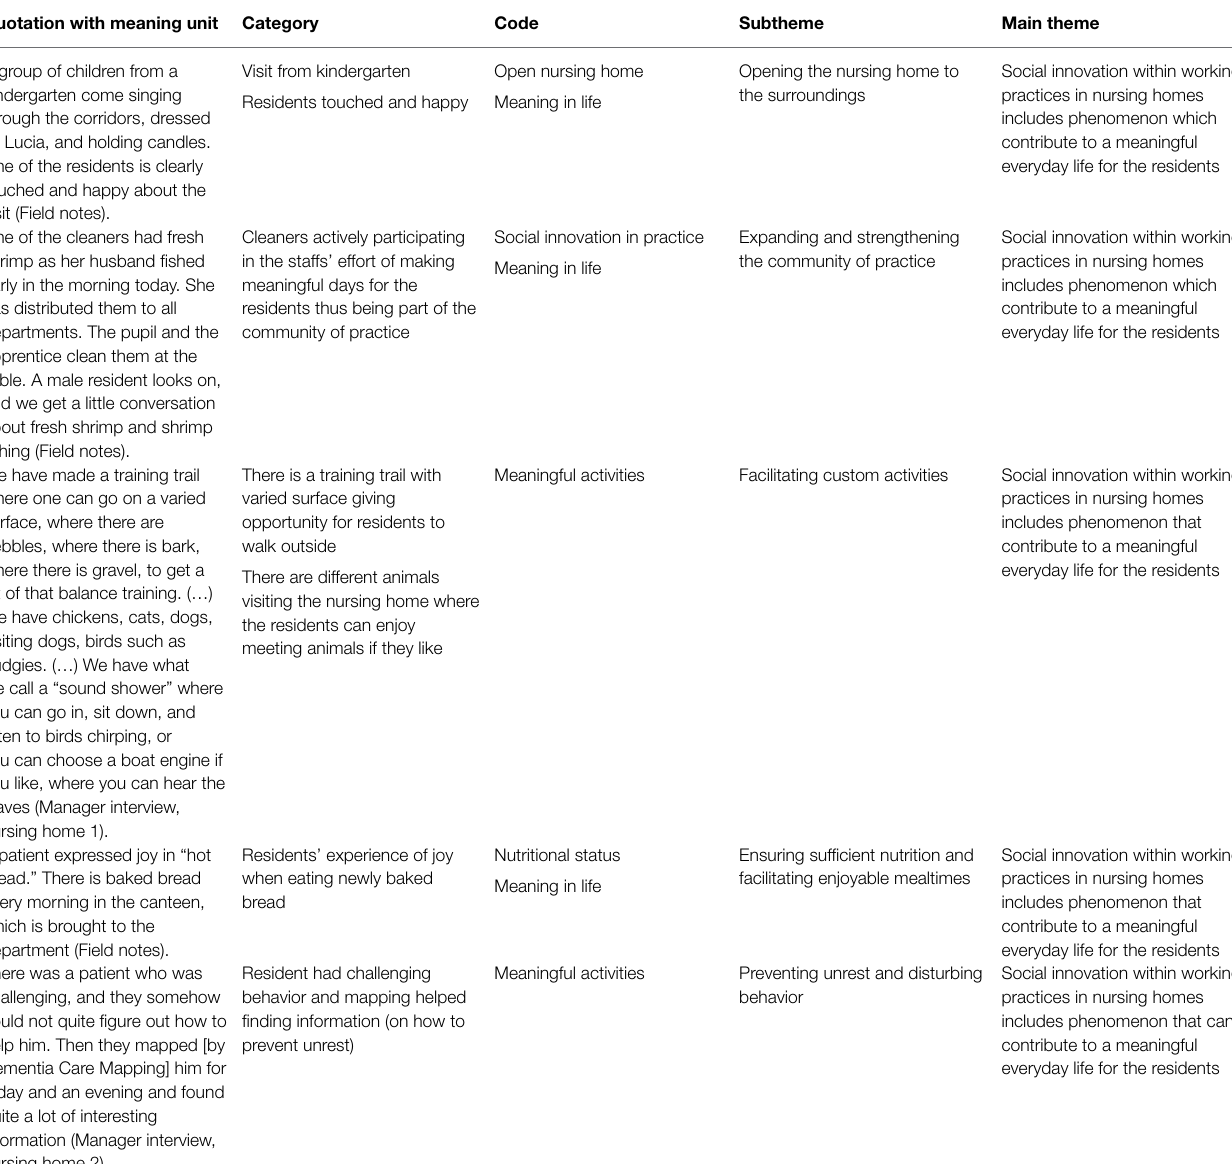
TABLE 1 | Examples of the analysis